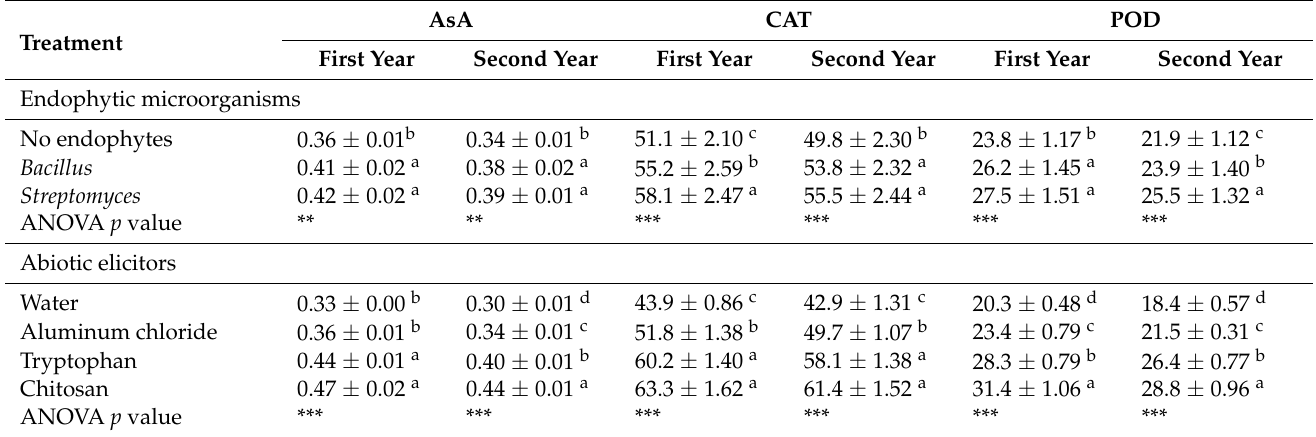
Table 4. Effect of endophytic microorganisms and abiotic elicitors on ascorbic acid (AsA; mg g − 1 FW), and activity (unit m − 1 protein) of catalase (CAT) and peroxidase (POD) enzymes in periwinkle plant shoot in both seasons (FW, fresh weight). Means of five replicates are presented with ±